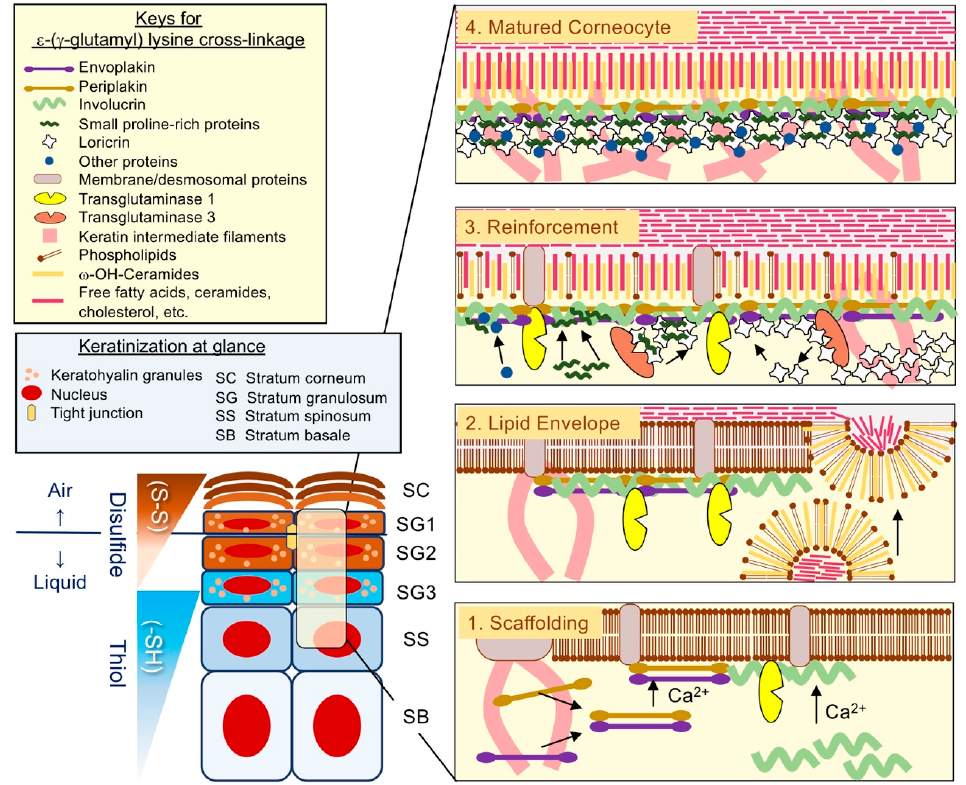
Figure 2. Keratinization at a glance—The epidermis encompasses a gradient of thiol (-SH) to adapt to xenobiotic insults encountered in terrestrial lifestyles. Loricrin (LOR) is a cysteine-rich cornified cell envelope (CE) protein that is critical in establishing the biochemical properties of the epidermis. The three-step model for CE assembly includes: 1. Stage one: scaffolding—Following the microenvironmental rise in Ca 2+ concentration, involucrin (IVL), envoplakin, and periplakin precipitate at the entire inner surface of the cell membrane. Transglutaminase 1 (TG1) catalyzes ε -( γ -glutamyl) lysine cross-linkages and the monomolecular layer forms. 2. Stage two: lipid envelope—The limited membrane of lamellar granules (LG) delivers long-chain ω -hydroxyceramides. TG1 catalyzes ester cross-linkages between the lipid and IVL. This replaces the cell membrane and forms the corneocyte lipid envelope. Free fatty acids, cholesterol, or ceramides extrude from LGs and form characteristic intercellular lamellae. 3. Stage three: Reinforcement—LOR accumulates in the cytoplasm in the stratum granulosum (SG). Steinert proposed that LOR oligomerization with small proline-rich proteins (SPRRs) (catalyzed by transglutaminase 3) is a critical step to enable an easy translocation to the cell periphery. At the SG1, the only living layer facing an air–liquid interface, LOR undergoes extensive disulfide formation. It thus stabilizes corneocytes after the completion of interchain-intrachain ε -( γ -glutamyl) lysine